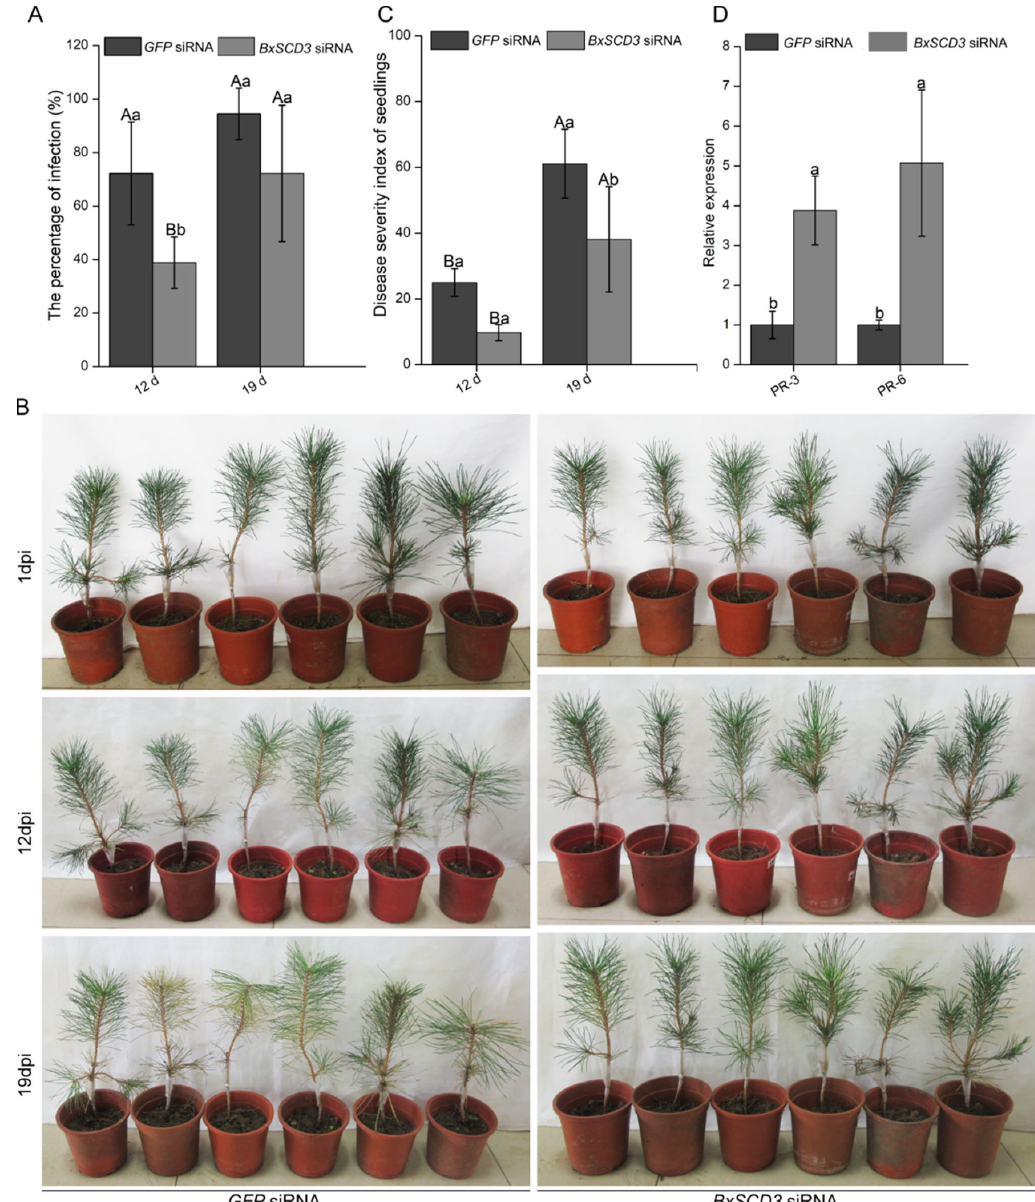
Figure 6. BxSCD3 contributes to the virulence of Bursaphelenchus xylophilus and inhibits the expression of defense-related genes in Pinus thunbergii . ( A ) The infection ratio of pine seedlings were calculated at 12 and 19 days post-inoculation (dpi). Three independent experiments were performed, and 18 individual P. thunbergii seedlings were used for each treatment. Data are the means, and the error bars represent ± SD from three biological replicates. Different letters on top of the bars indicate statistically significant differences ( p < 0.05, t -test) as measured by Duncan’s multiple range test. ( B ) The symptoms of P. thunbergii at 12 and 19 dpi with two different nematode treatments ( BxSCD3 siRNA and GFP siRNA). ( C ) The disease severity index of pine seedlings were calculated at 12 and 19 days dpi. Data are the means, and the error bars represent ± SD from three biological replicates. Different letters on top of the bars indicate statistically significant differences ( p < 0.05, t -test) as measured by Duncan’s multiple range test. ( D ) The relative expression levels of pathogenesis-related genes PtPR-3 and PtPR-6 in P. thunbergii infected with BxSCD3 siRNA-treated nematodes. The seedlings infected with GFP siRNA-treated nematodes were used as controls. Data are the means, and the error bars represent ± SD from three biological replicates. Different letters on top of the bars indicate statistically significant differences ( p < 0.05, t -test) as measured by Duncan’s multiple range